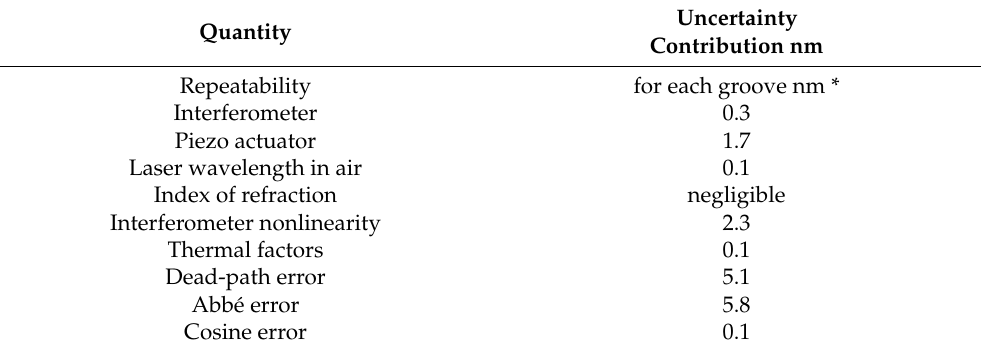
Uncertainty Contribution nm